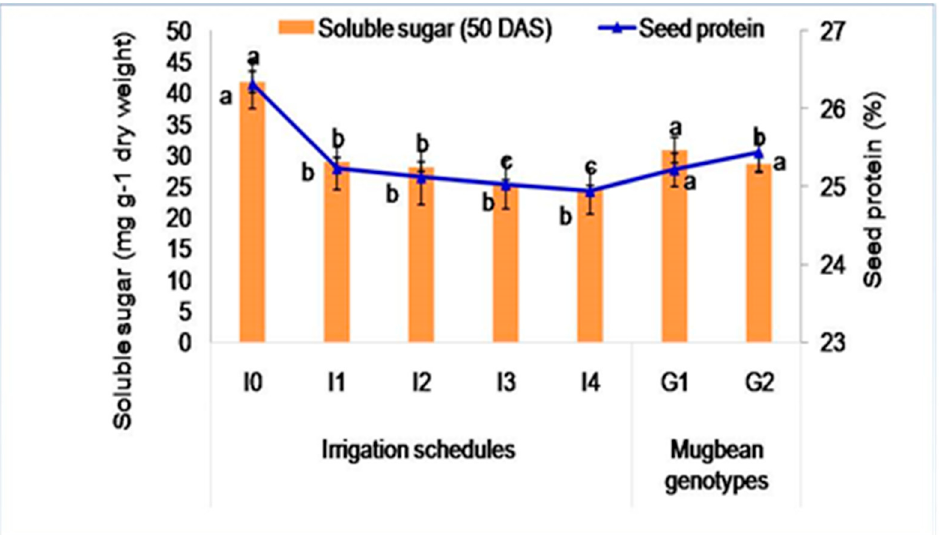
Figure 6. Soluble sugar and seed protein content under different irrigation schedules and selected mungbean genotypes (Data followed by the same letter are not differed significantly by LSD test at p < 0.05).